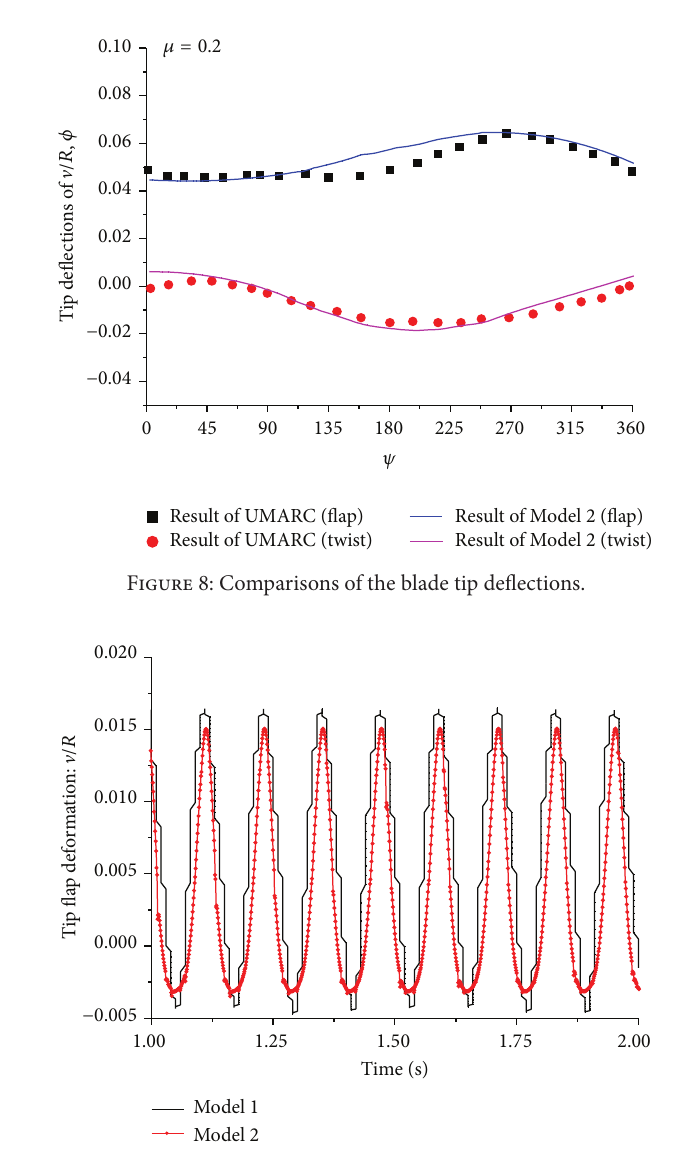
Figure 9: Result comparisons of Model 1 and Model